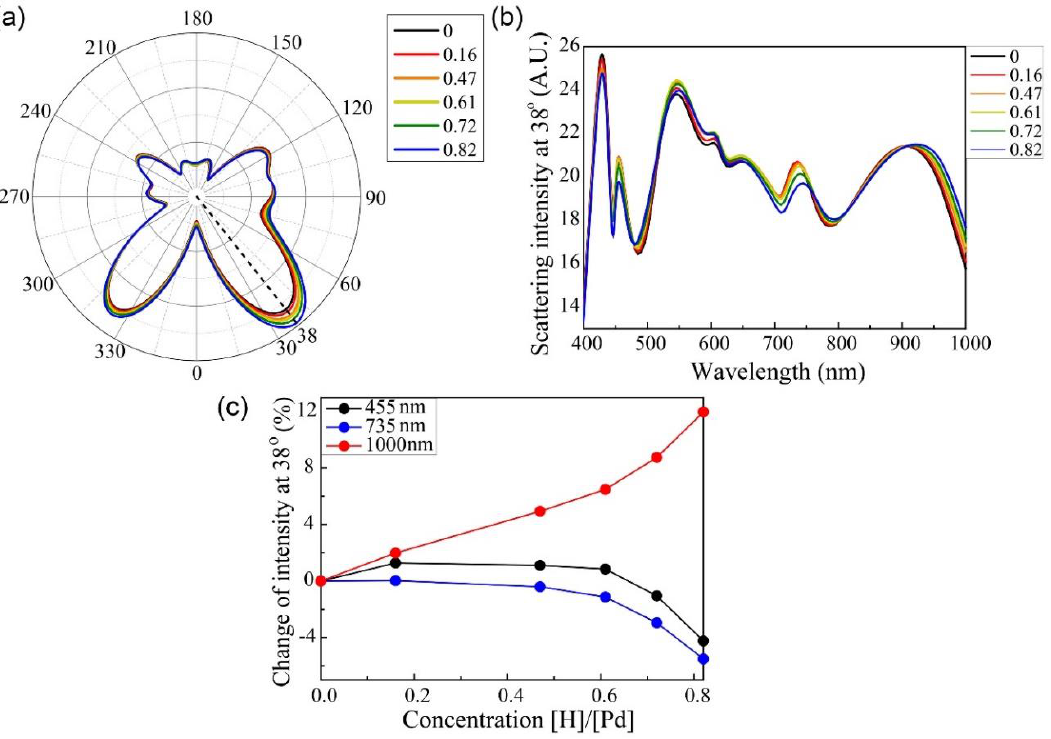
Figure 3. ( a ) Far-field scattering radiation at 1000 nm with respect to hydrogen concentration. ( b ) Far-field scattering at 38° for wavelengths of 400 – 1000 nm. ( c ) Differences in the far-field scattering intensities at three different wavelengths for hydrogen concentrations of 0 – 0.82 at 38°.